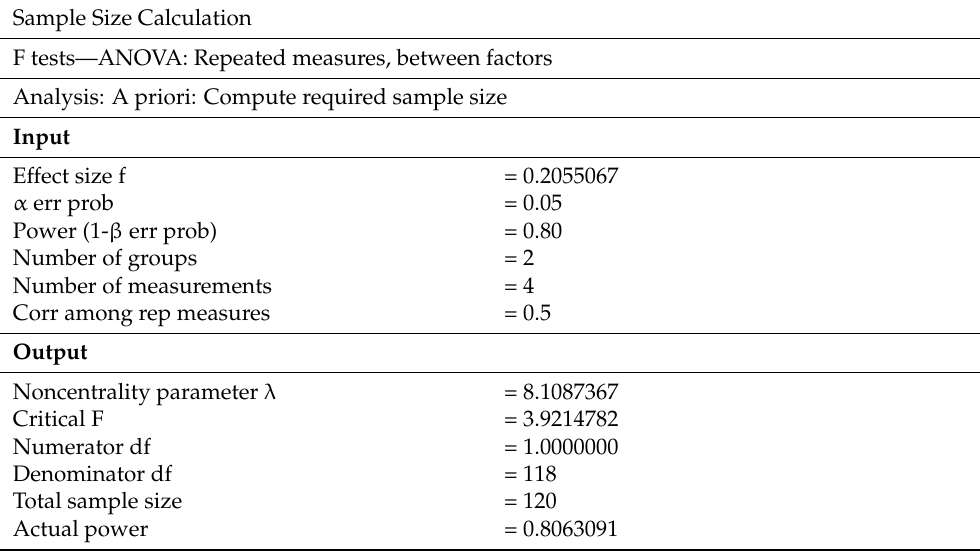
Table 2. Protocol for calculation in G*Power. Sample Size